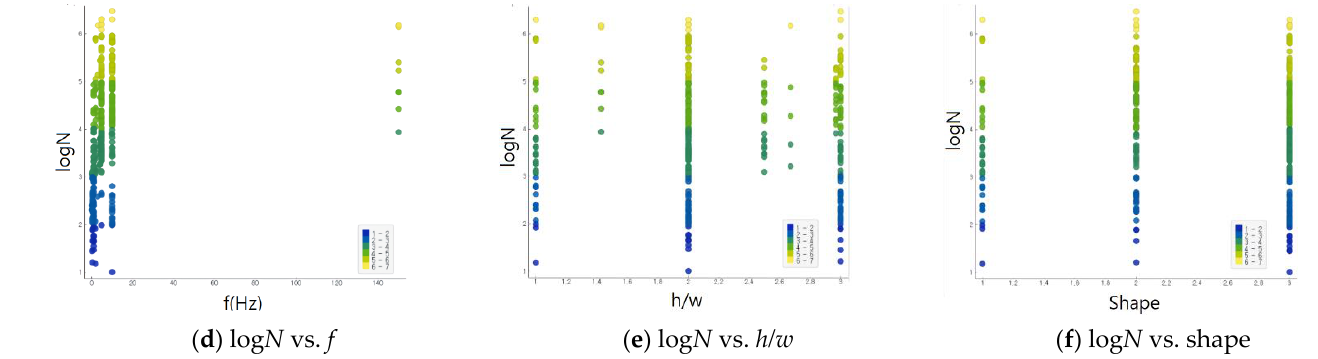
Figure 2 . Scattered plot between independent and dependent variables. Figure 2. Scattered plot between independent and dependent variables.